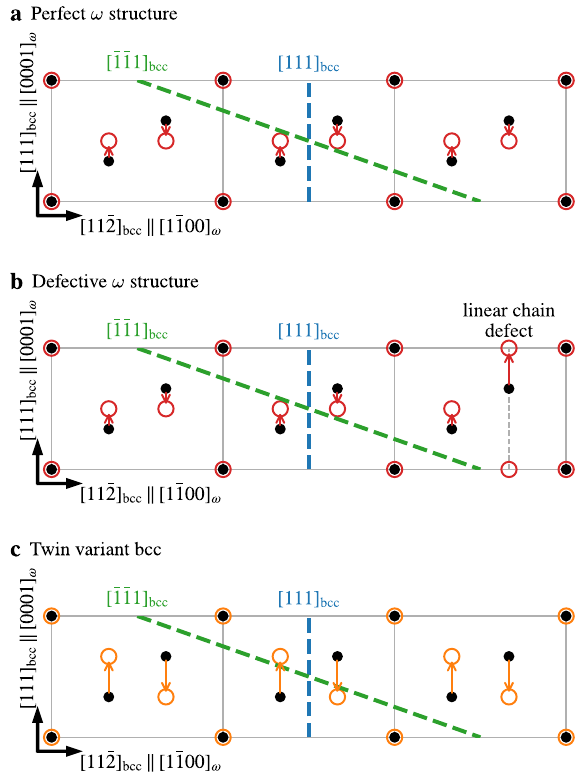
Fig. 2 Schematics of the bcc – ω transformation. Black and red circles represent the bcc and the ω lattice sites, respectively. a Perfect ω structure. b Defective ω structure. c Twin variant of the original bcc structure, obtained from the twice larger displacements for the perfect ω structure. Orange circles represent the twin-variant bcc lattice